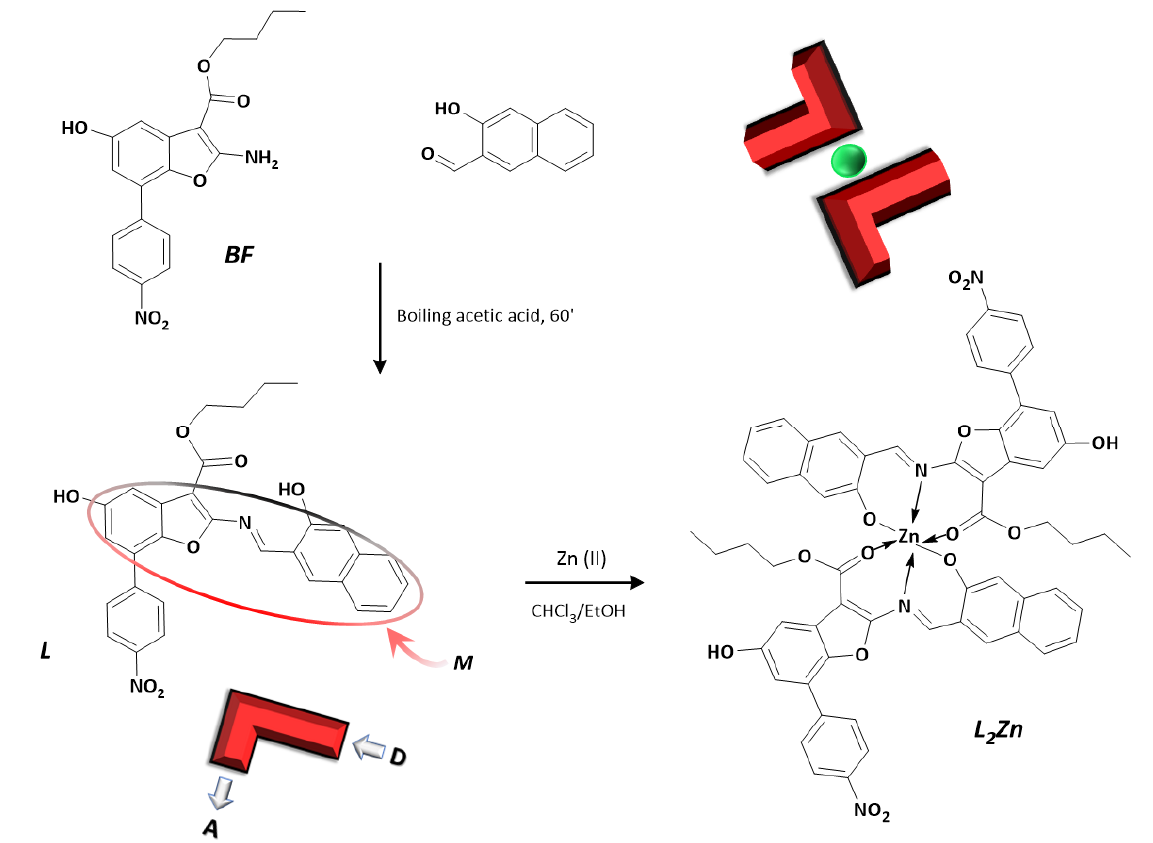
Scheme 1. Synthetic route to the target compounds L and L 2 Zn. M is the main plane containing the benzofuran ring condensed with the 3-hydroxy-2-naphthaldehyde moiety. The cartoon representation is used for showing a quick glance of the donor–acceptor L-shaped pattern in the ligand L and in the complex L 2 Zn.